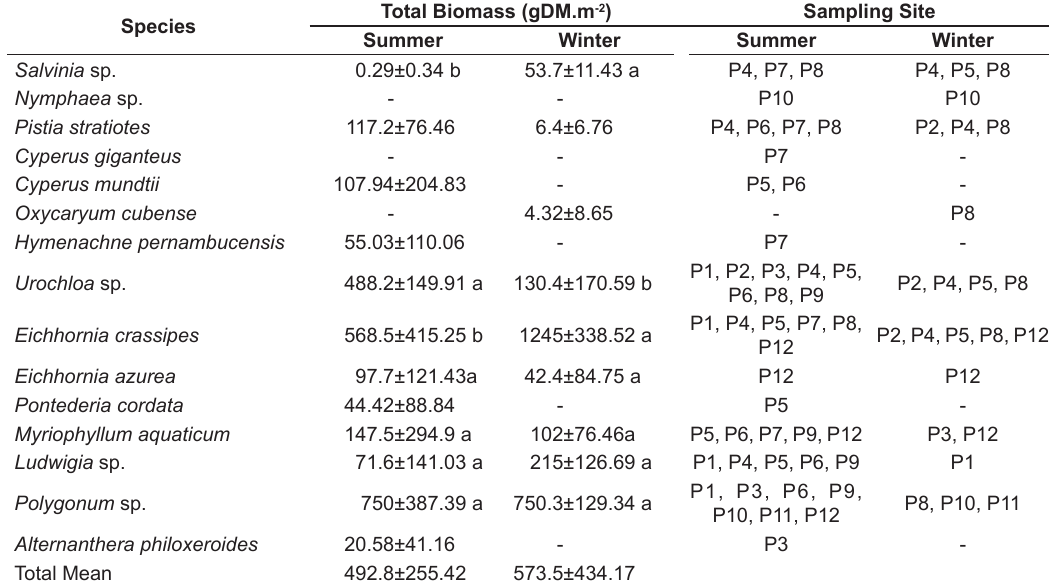
Table 2. Occurrence of aquatic macrophytes species in the different sampling sites from Itupararanga Reservoir and their total biomass in the summer (February, 2010) and in the winter (June, 2010). The t test was not performed on the species occurring in only one period and to Pistia stratiotes due to the low abundance in the winter. Species Salvinia sp.